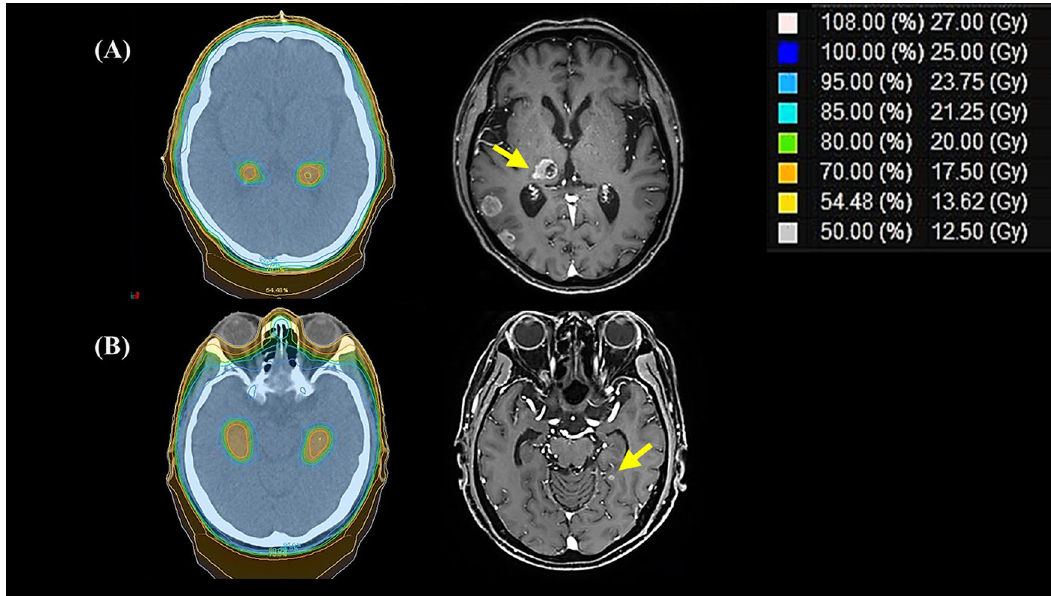
Figure 2. Radiation dose distribution and sites of intracranial failure (ICF) in two patients with peri- hippocampal recurrences after hippocampal-avoidance prophylactic cranial irradiation. Patient ( A ) was a 73-year-old man, and ICF developed 17 months after HA-PCI. Patient ( B ) was a 60-year-old man, and ICF developed 3 months after